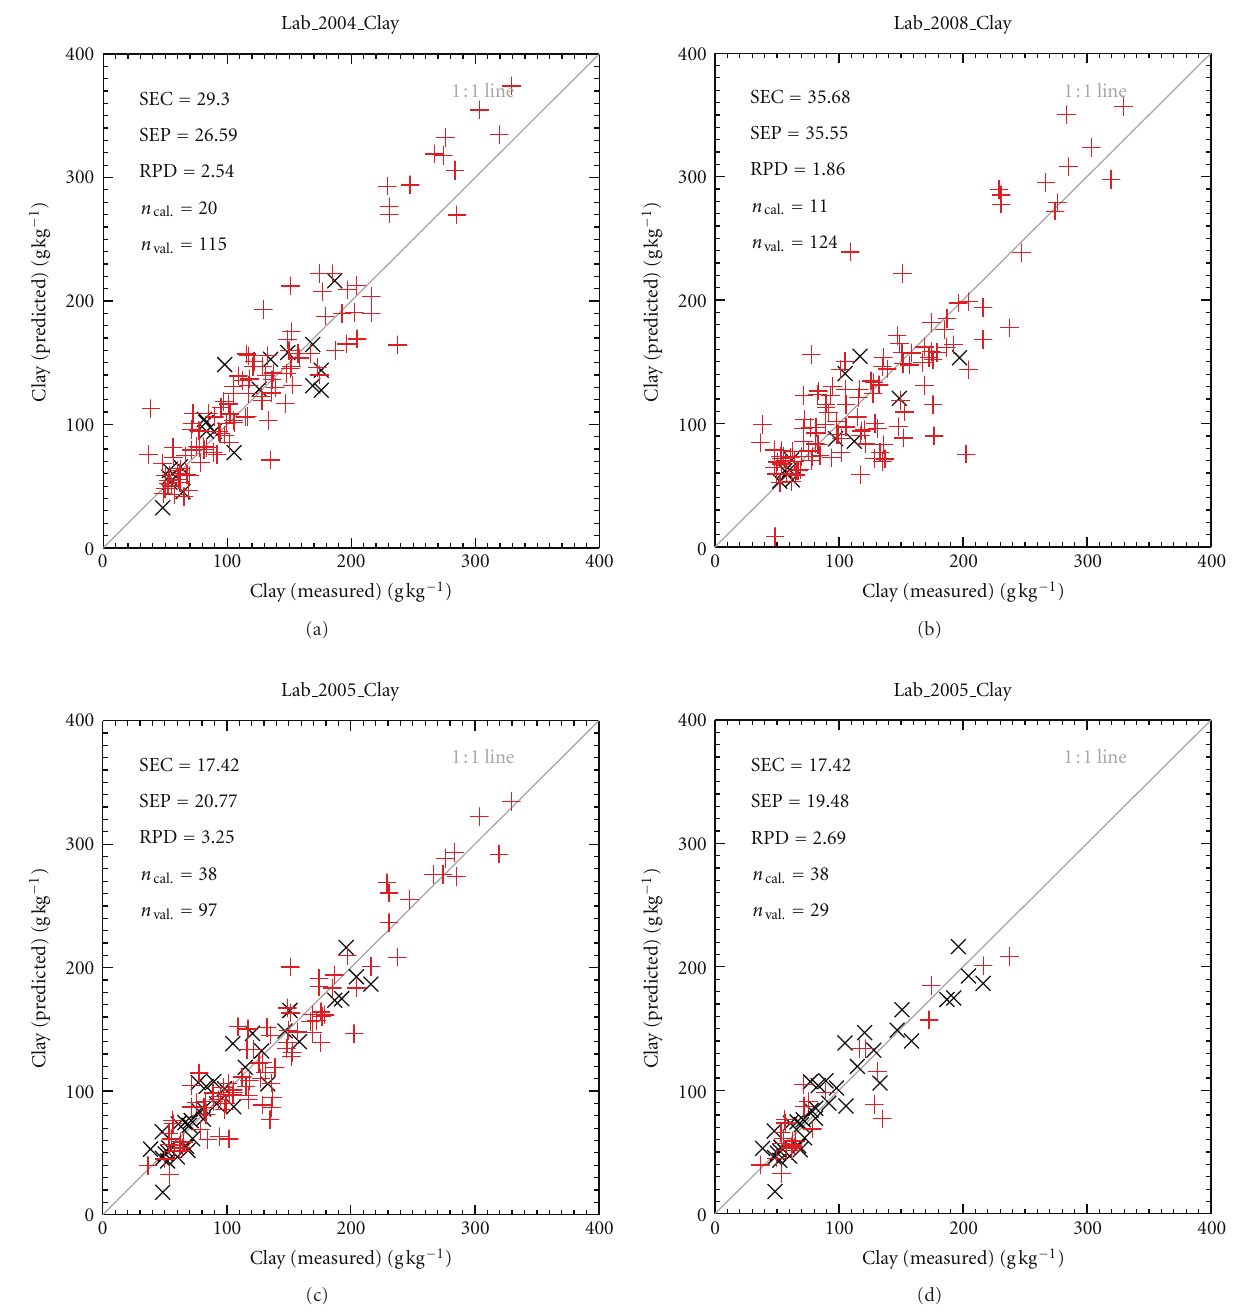
Figure 7: Plots of measured versus predicted values for clay (g kg − 1 ) in the calibration (black symbol, × ) and validation (red symbol, +) data sets based on laboratory spectra. The respective calibration and validation data schemes ( n cal . / n val . ) are marked on the plots. For further explanation see